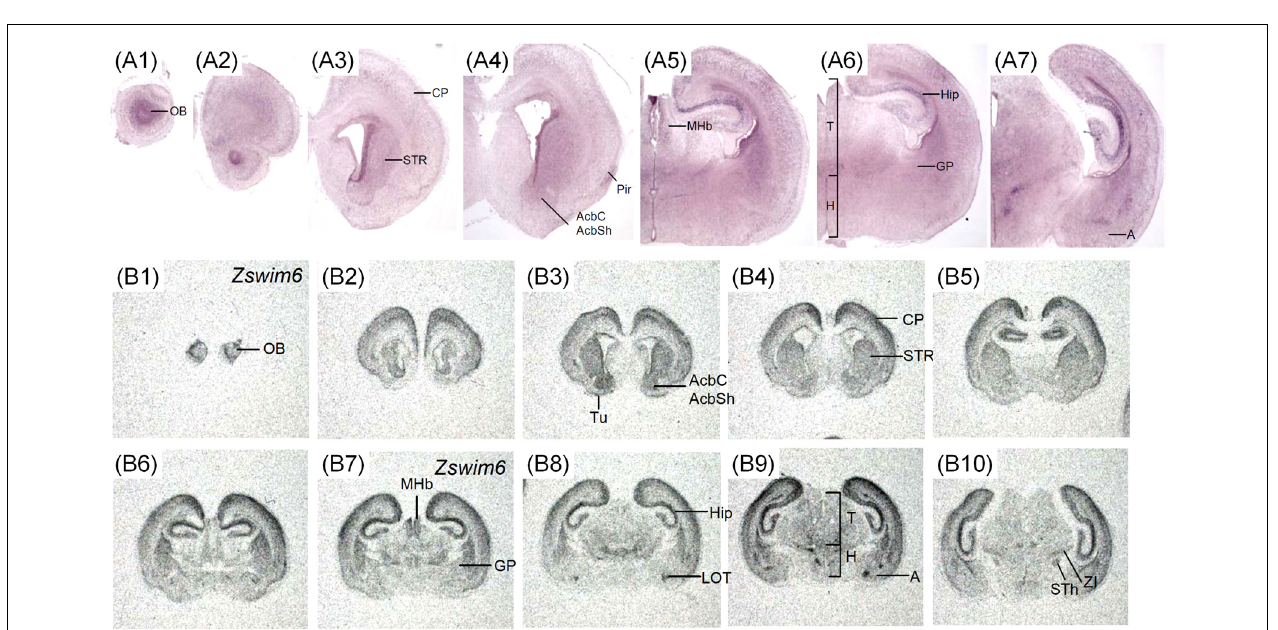
FIGURE 6 | Zswim6 mRNA expression pattern in P0 mouse forebrain. Zswim6 mRNA signals were detected by in situ hybridization with digoxigenin-labeled probes (A1–A7) and 35 S-labeled probes (B1–B10) from rostral to caudal levels at P0. Moderate to strong Zswim6 signals were expressed in the olfactory bulb, dorsal and ventral striatum, cortex, hippocampus, thalamus, amygdala and medial habenular nucleus. A, amygdala; AcbC, nucleus accumbens, core; AcbSh, nucleus accumbens, shell; AO, anterior olfactory nucleus; Cere, cerebellum; Cg, cingulate cortex; CP, cortical plate; CTX, cortex; DG, dentate gyrus; GP, globus pallidus; GrO, granular cell layer of the olfactory bulb; H, hypothalamus; Hip, hippocampus; MHb, medial habenular nucleus; Mi, mitral cell layer of the olfactory bulb; ne, neuroepithelium; OB, olfactory bulb; Pir, piriform cortex; T, thalamus; Tu, olfactory tubercle; STh, subthalamic nucleus; STR, striatum; ZI, zona incerta.